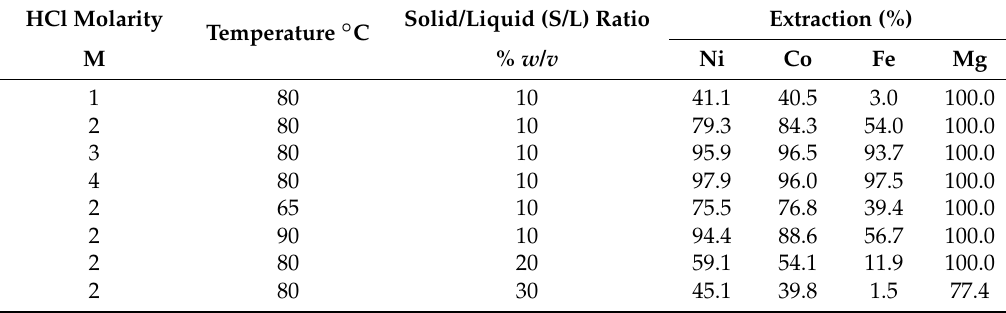
Table 2. Metal extraction (%) from the saprolitic ore after six hours leaching with HCl. HCl